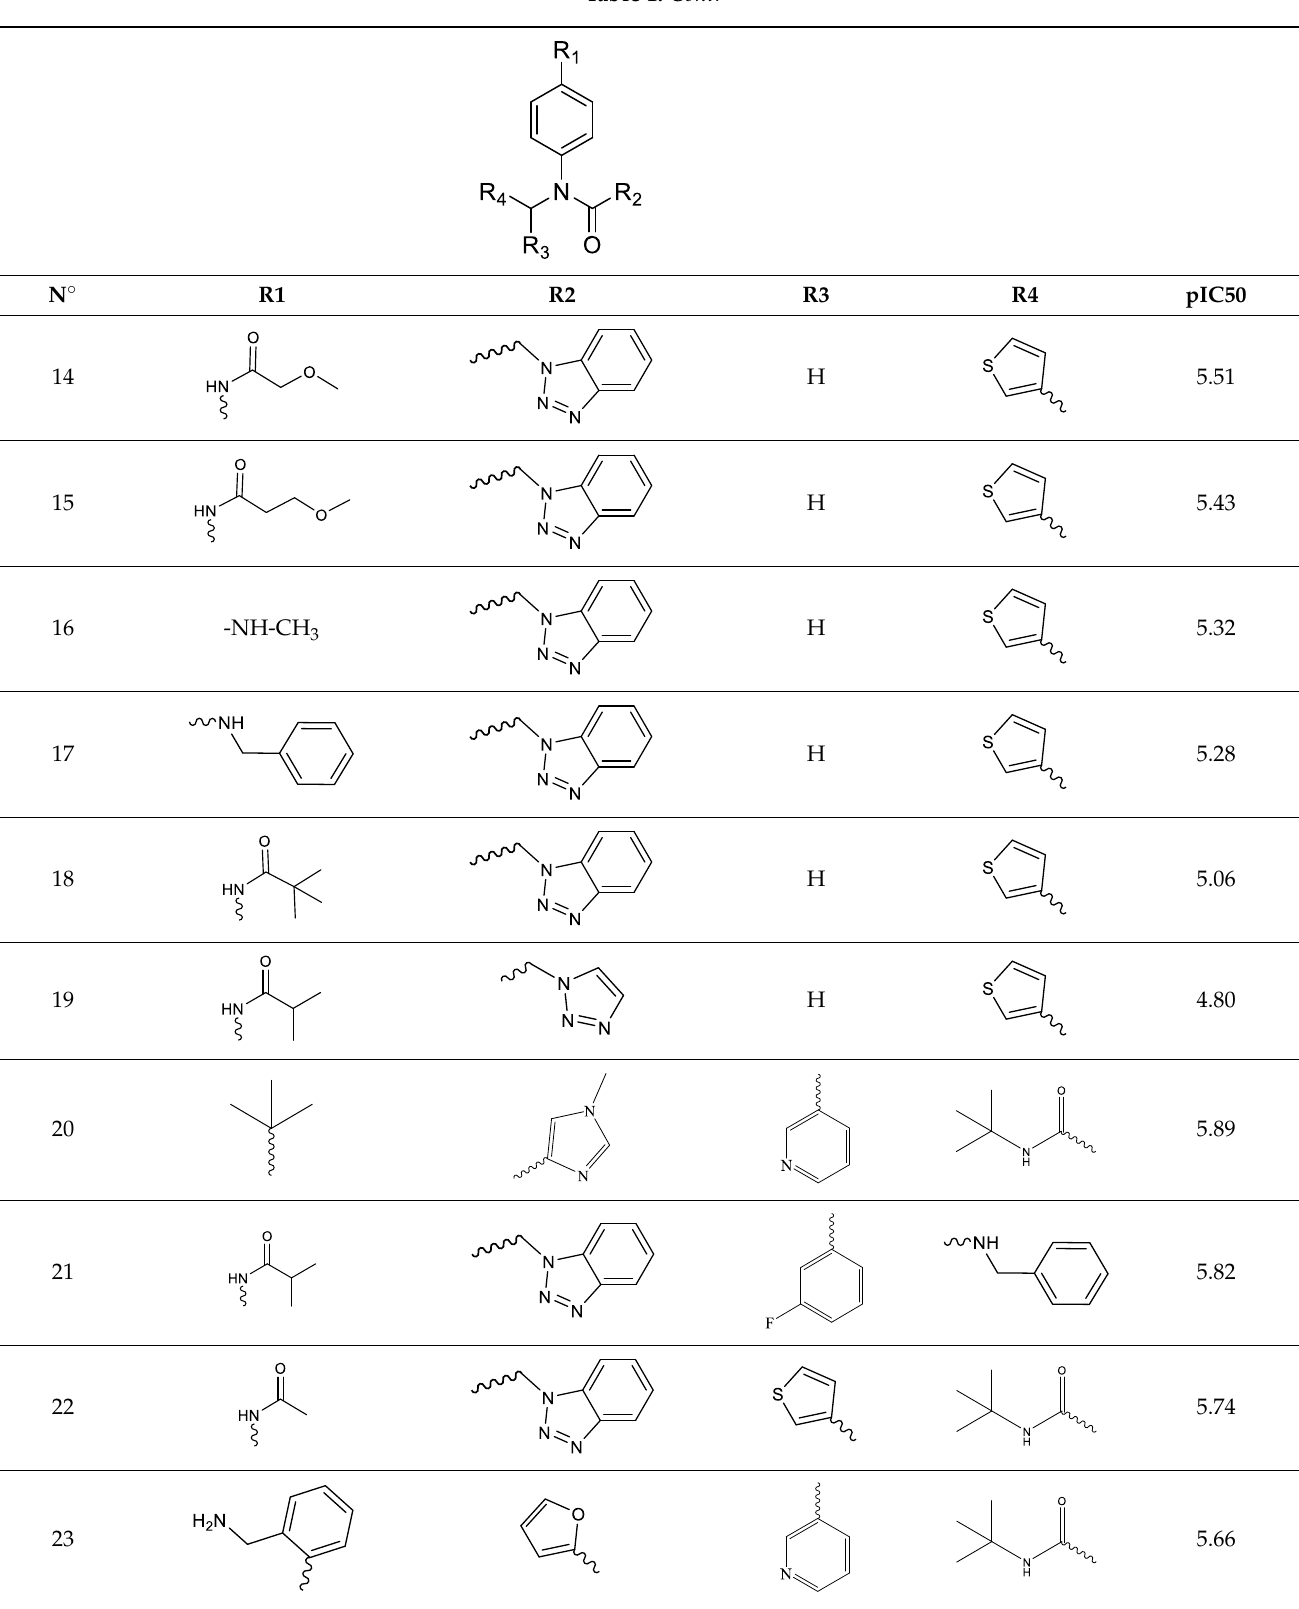
Table 1. Cont. Table 1. Chemical structures and activity experiment of 41 peptidomimetic compounds.